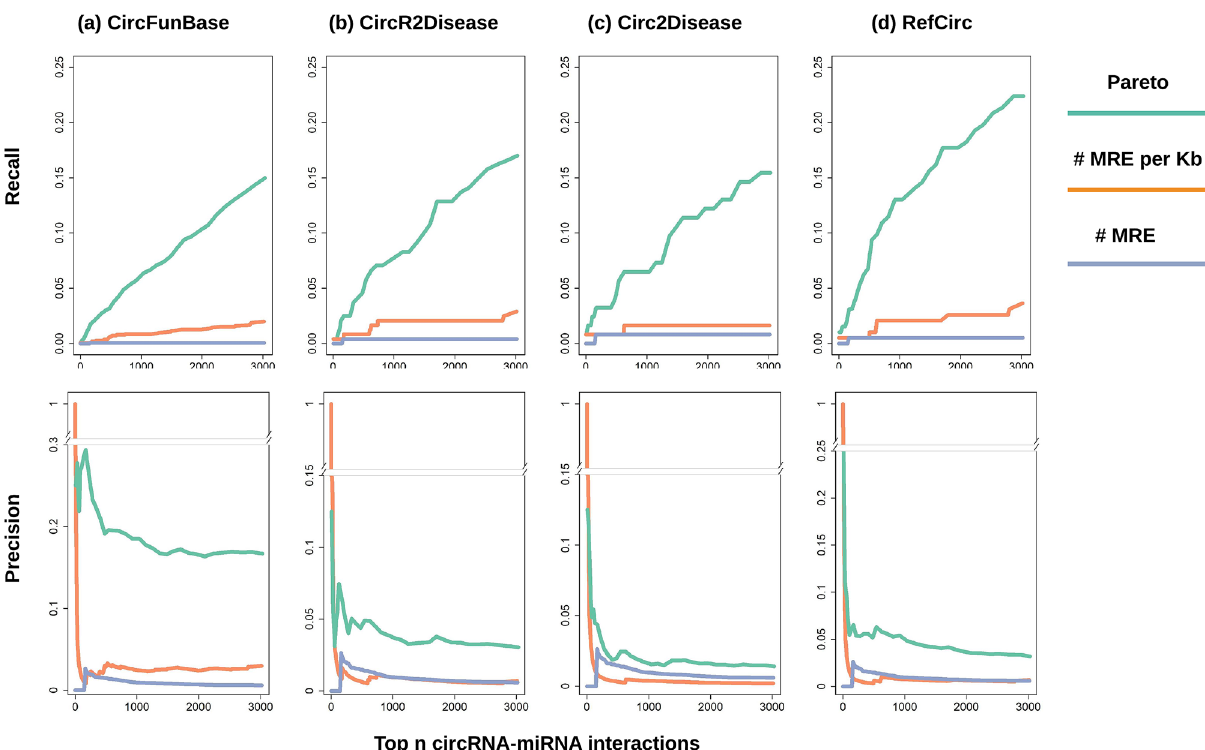
Figure 3. Evaluating the performance of different circRNA-miRNA interaction ranking methods using data from several circRNA function/disease databases. Upper panel: recall (sensitivity) curve. Lower panel: precision. R package plotrix v3.7–8 (https ://cran.r-proje ct.org/web/packa ges/plotr ix/index .html) was used to create gap